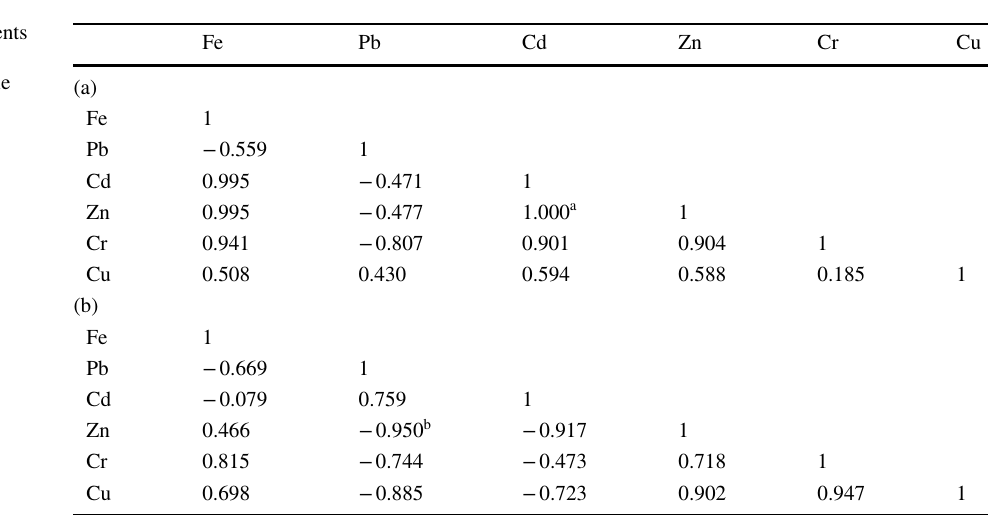
a Correlation was significant at the 0.01 level b Correlation was significant at the 0.05 Table 8 Principal component analysis of borehole and well water samples ( n = 42) Borehole